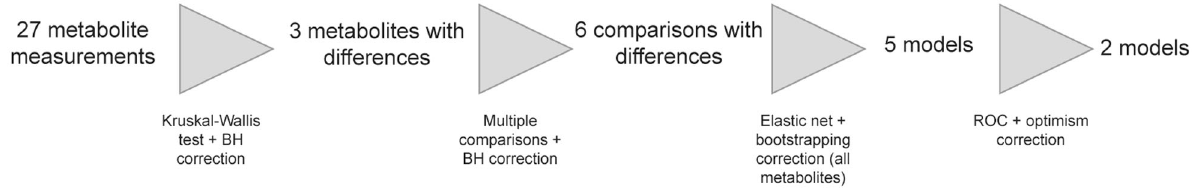
Fig. 2 Schematic representation of model building work fl ow. Scheme illustrating the input/output of each step done for building models to discriminate between groups, and the statistical methods used to perform them. BH Benjamini – Hochberg, ROC receiver operating